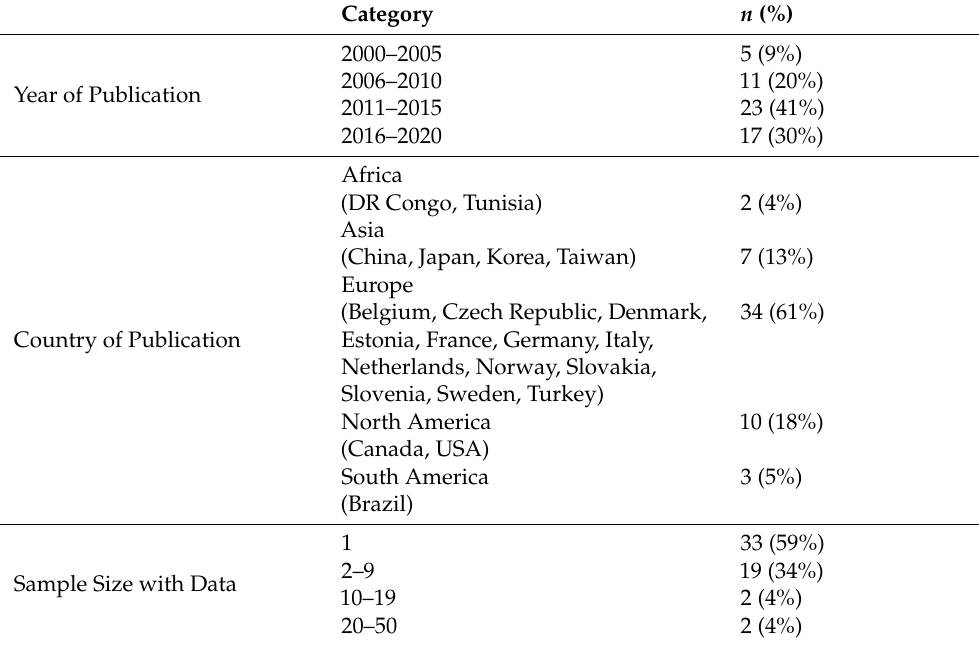
Table 1. Description of 56 published articles with information on genetic data and head size. Category n